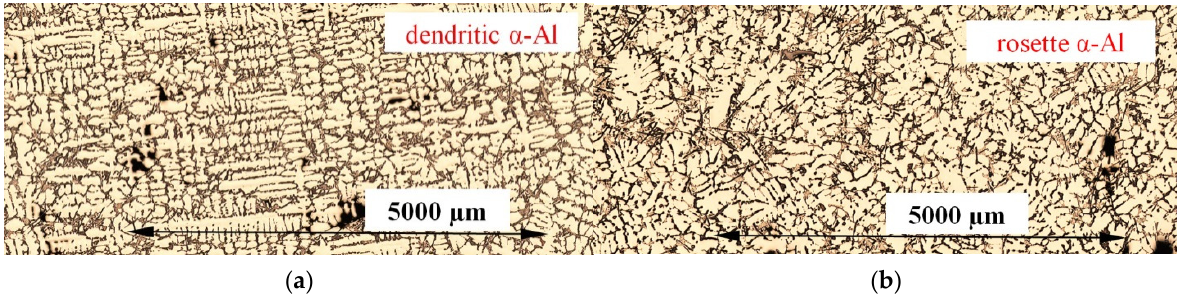
Figure 4. Microstructures of the AlCu4Si6Fe1 specimen solidified: ( a ) without and ( b ) with electromagnetic stirring. LOM, magnification 50×.